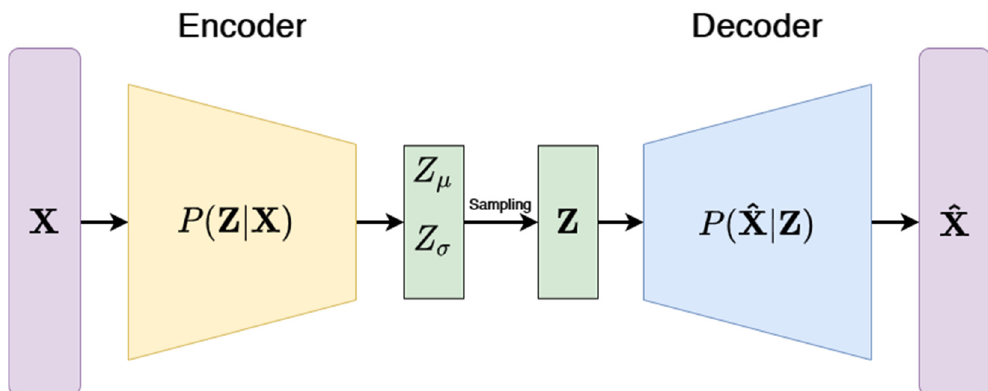
Figure 9. Architecture illustration of the variational autoencoder. Encoder compresses the input X into a latent representation Z. VAE is different to a standard autoencoder as it assumes that the input data have an underlying probability distribution (e.g., Gaussian) for which they try to optimize parameters. The decoder then attempts to reconstruct the original input from the representation by minimizing the reconstruction loss.